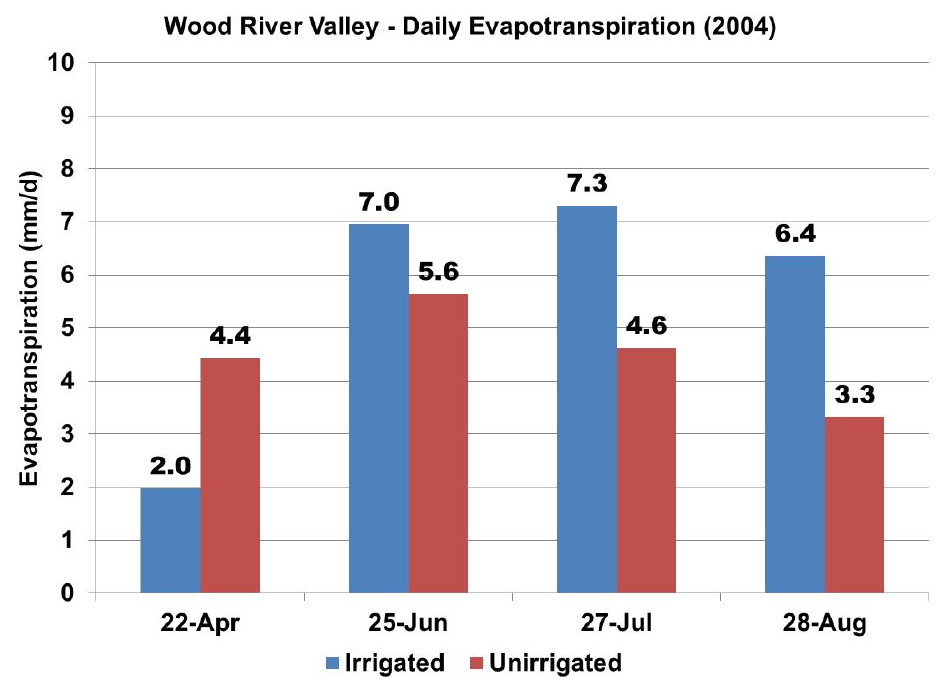
Figure 10. Results of reconstructed ET algorithm integrated to daily ET values at the irrigated and unirrigated sites.